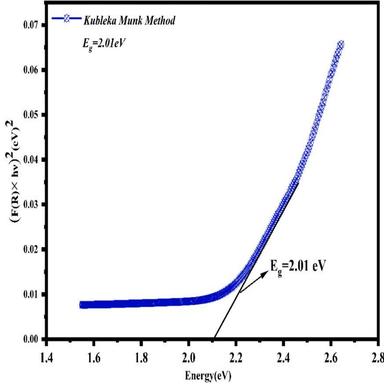
Plot of (F(R) hν) 2 against energy.